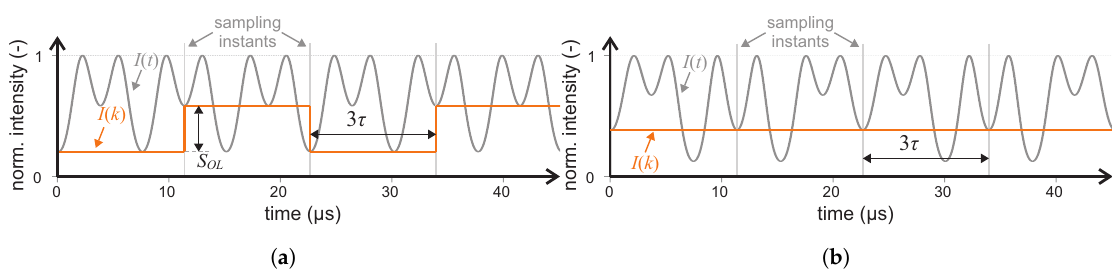
Figure 6. The time diagrams of the photodetected signals in the original I ( t ) and discrete I ( k ) forms, and the sampling instants for the uncompensated ( a ) and compensated ( b ) Sagnac phase shift. In ( a ), the sample difference corresponds to the error signal, whereas in ( b ) the zero error signal is